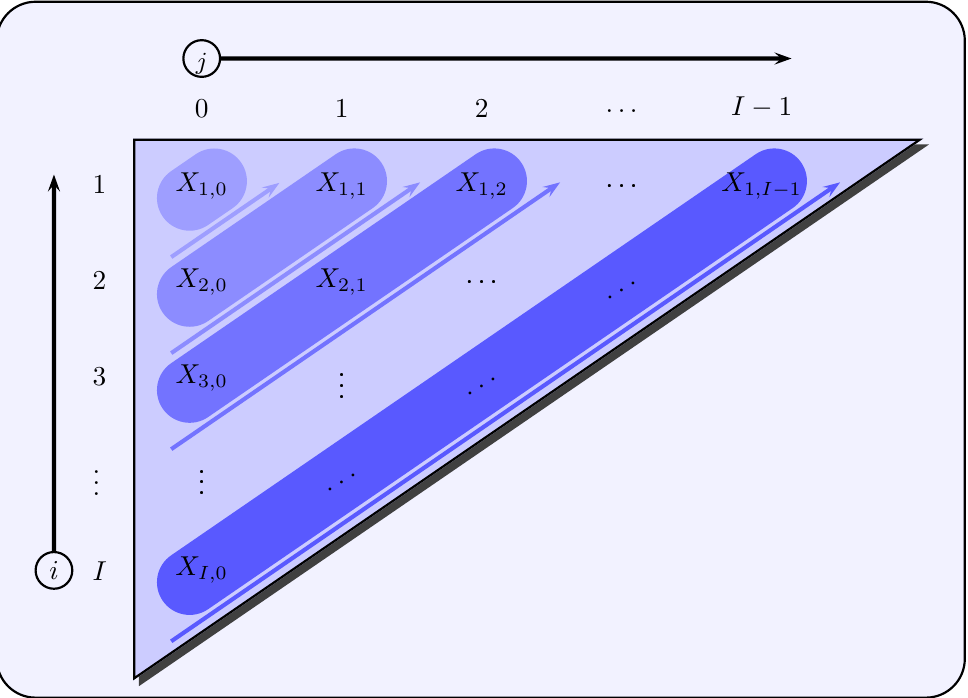
Figure 2. Modeling the payment stream of incremental